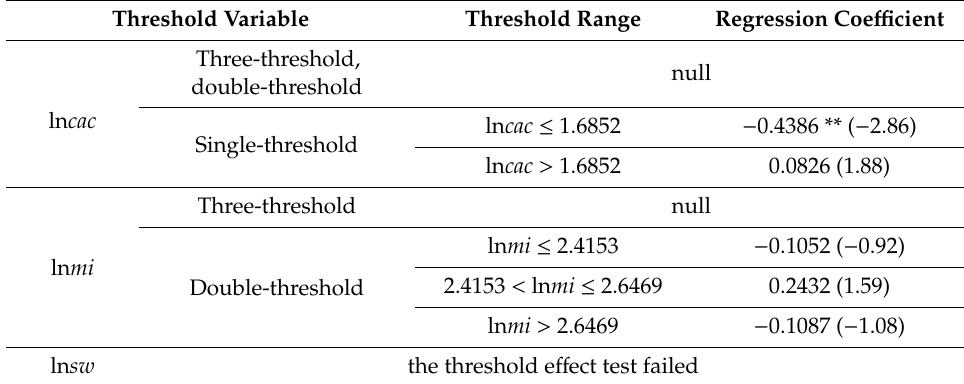
Table 4. Regression results of threshold e ff ect of di ff erent types of environmental policy instruments and green technology innovation.